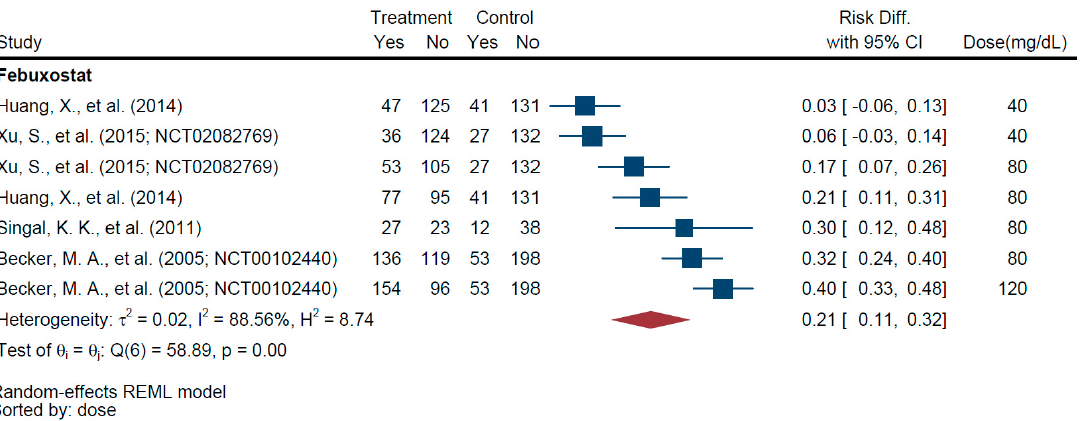
Figure 2. Forest Plot of Achievement Difference in Febuxostat Monotherapy vs. Allopurinol 300 mg QD–SUA < 6 mg/dL [30,31,35,64]. Table 5. Serum uric acid-lowering Achievement Difference vs. allopurinol 300 mg daily.